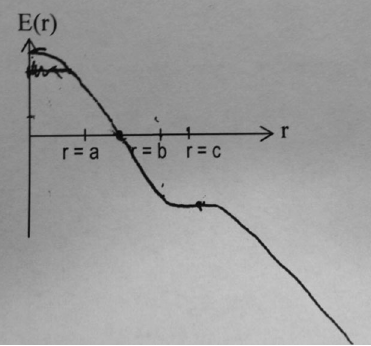
FIG. 4. Electric field plotted by Alex (an interviewed student).